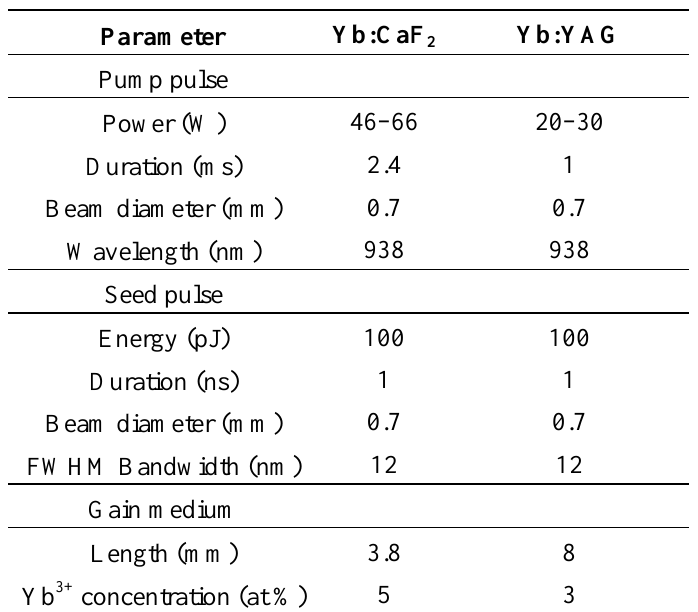
Table 1. Parameters used in the numerical